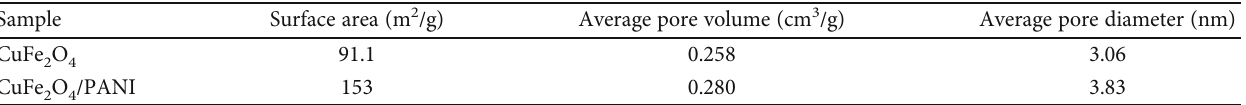
O /PANI nanocomposite. 2 4